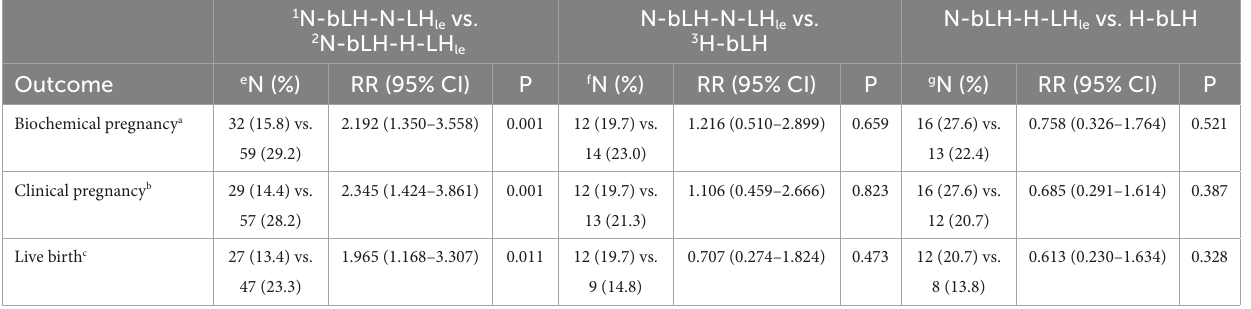
TABLE 3 Live birth, pregnancy, and pregnancy loss adjusted by 1:1 PS matching *